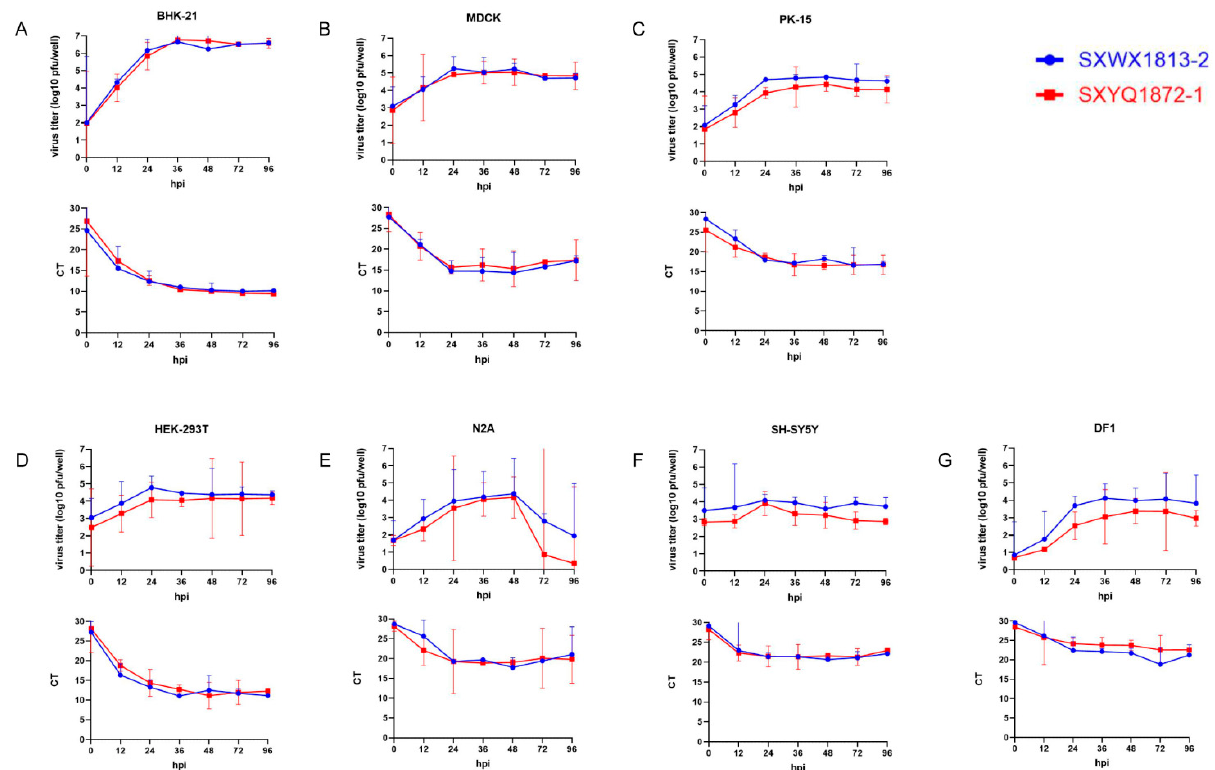
Figure 3. Viral and genomic replication of WUXV SXWX1813 ‐ 2 and SXYQ1872 ‐ 1 in different cell lines. ( A ) BHK ‐ 21, ( B ) MDCK, ( C ) PK ‐ 15, ( D ) HEK ‐ 293T, ( E ) N2A, ( F ) SH ‐ SY5Y and ( G ) DF1 cell monolayers were infected with WUXV SXWX1813 ‐ 2 and SXYQ1872 ‐ 1 at a multiplicity (MOI) of 0.05, respectively. Cell and supernatant samples were collected at 0, 12, 24, 36, 48, 72, and 96 hpi. Upper panels show the viral titers that quantified by standard plaque assay and express as pfu/well for SXWX1813 ‐ 2 (blue) and SXYQ1872 ‐ 1 (red) fractions. Lower panels show the viral nucleic acid level